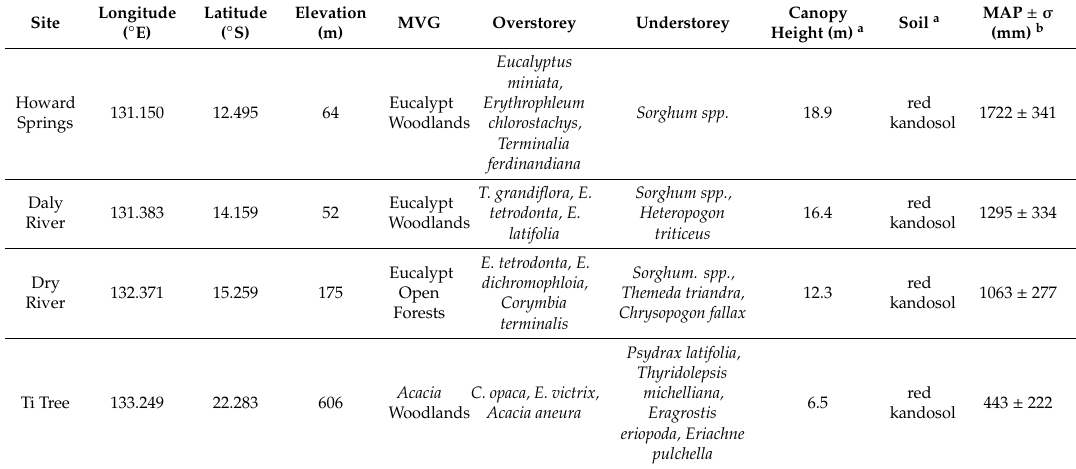
Table 1. Summary of vegetation types and climatology of four local sites in the